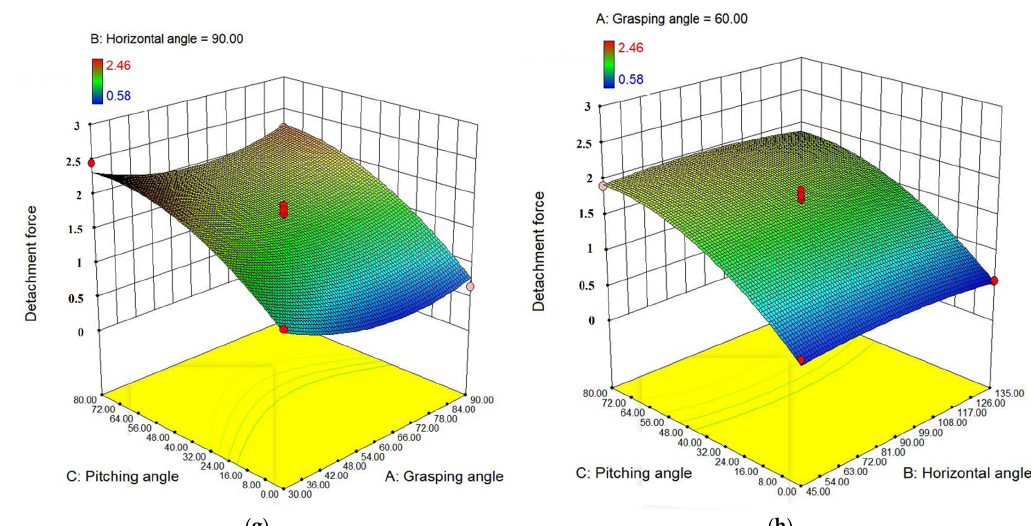
Figure 4. ( a ) Residuals plot; ( b ) relationship between predicted value and actual value; ( c ) the effect of grasping angle on detachment force; ( d ) the effect of horizontal angle on detachment force; ( e ) the effect of pitching angle on detachment force; ( f ) interaction plots for the interactive effects of grasping angle, and horizontal angle on detachment force; ( g ) interaction plots for the interactive effects of grasping angle, and pitching angle on detachment force; ( h ) interaction plots for the interactive effects of pitching angle, and horizontal angle on detachment force.